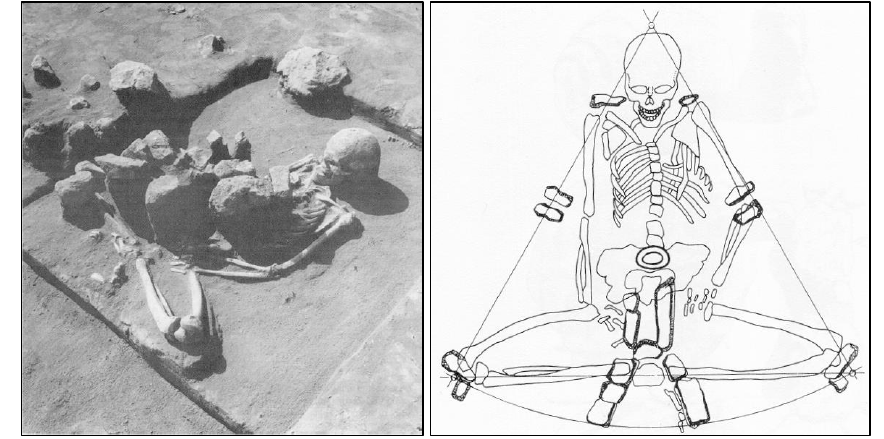
Figure 15. Skeleton located in the triangular shape on Lepenski Vir I.